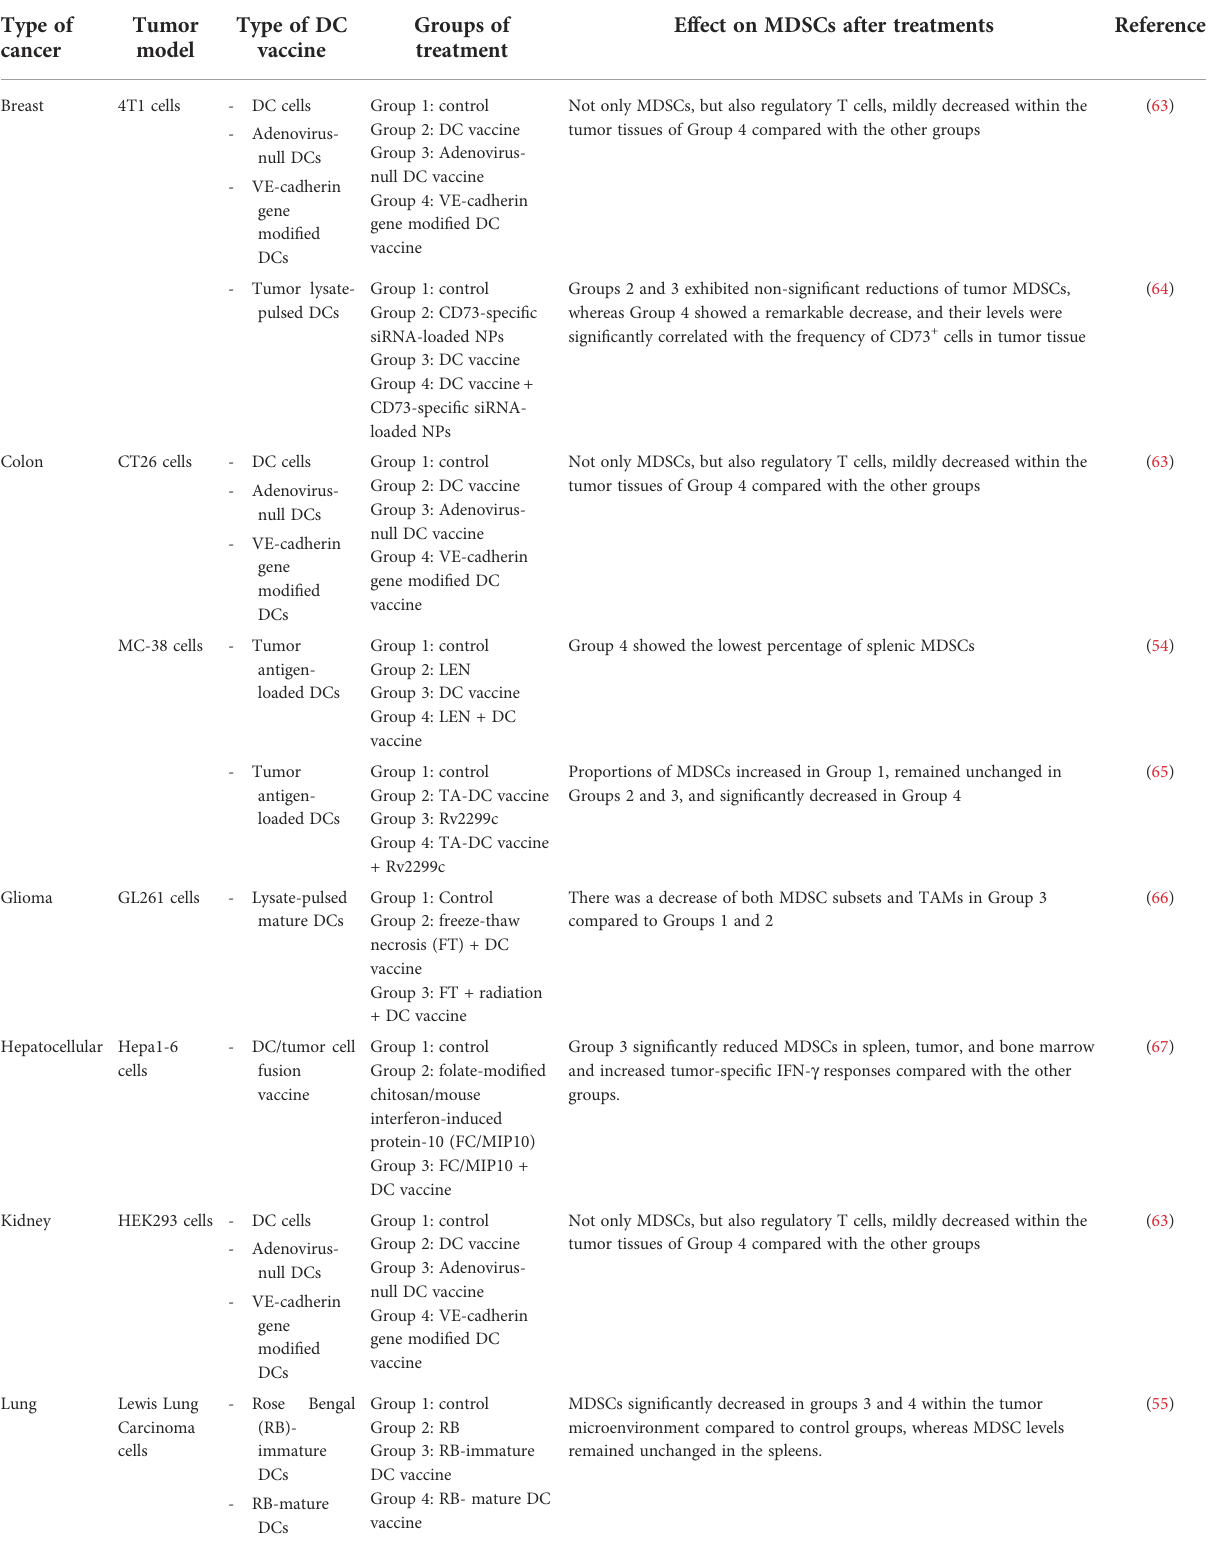
TABLE 1 Preclinical studies involving the use of dendritic cell-based vaccines (alone and combined with other treatments) and their effects on the myeloid-derived suppressor cell population. Type